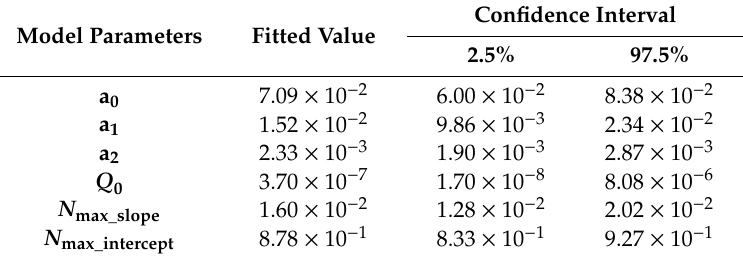
Table 3. Model constants for fitted model and their 95% confidence interval.